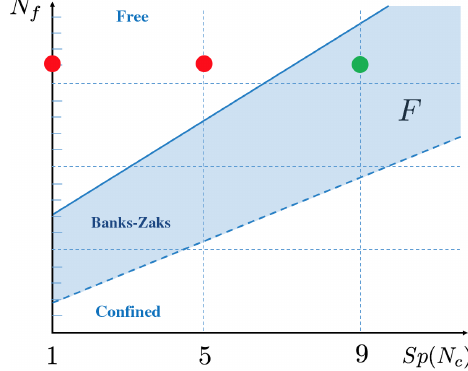
FIG. 5. A sketch for the conformal window of Sp ð N gauge c Þ theories (numbers on the N axis are not precise). The red and f green dots are different gauge theories. The red ones are free, and the green one is strongly interacting. However, they all describe the topological phase transition from the trivial state to the same PSp ð N × Z T 2 bosonic symmetry-protected topological f Þ